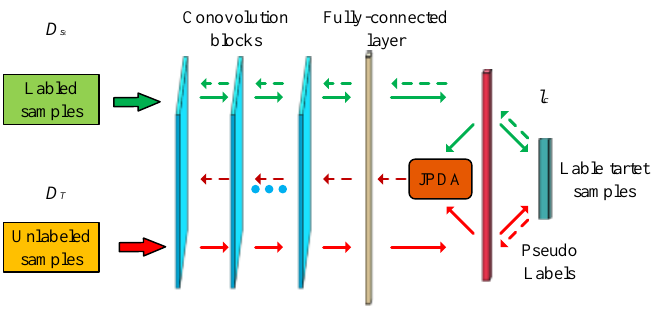
Figure 3. Structure of TCNN s